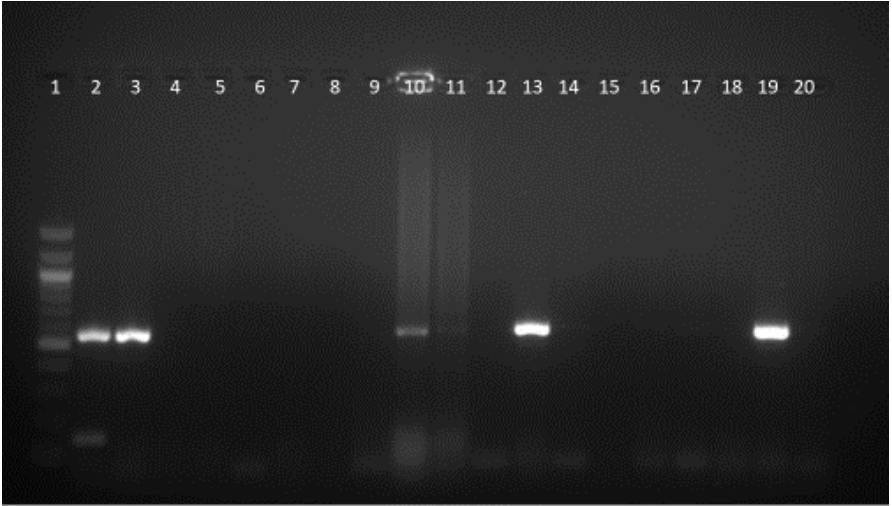
Figure S2 : Virulence genes (multiplex PCR amplification). Lane 1: 100bp ladder; Lane 20; Negative control; Lane 19: positive control; Lane 3: Positive invA isolate (570bp); Lane 4-9;